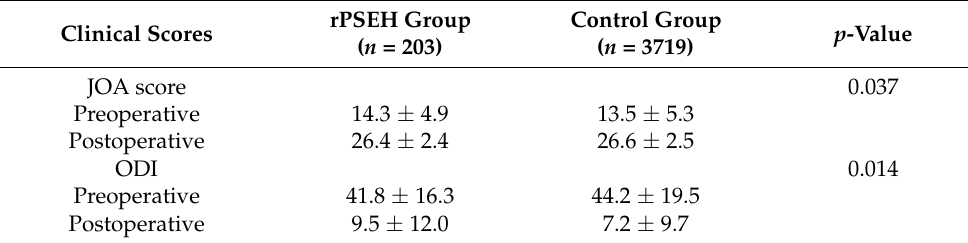
Table 5. Clinical scores compared between the patients with and without rPSEH using mixed- effects